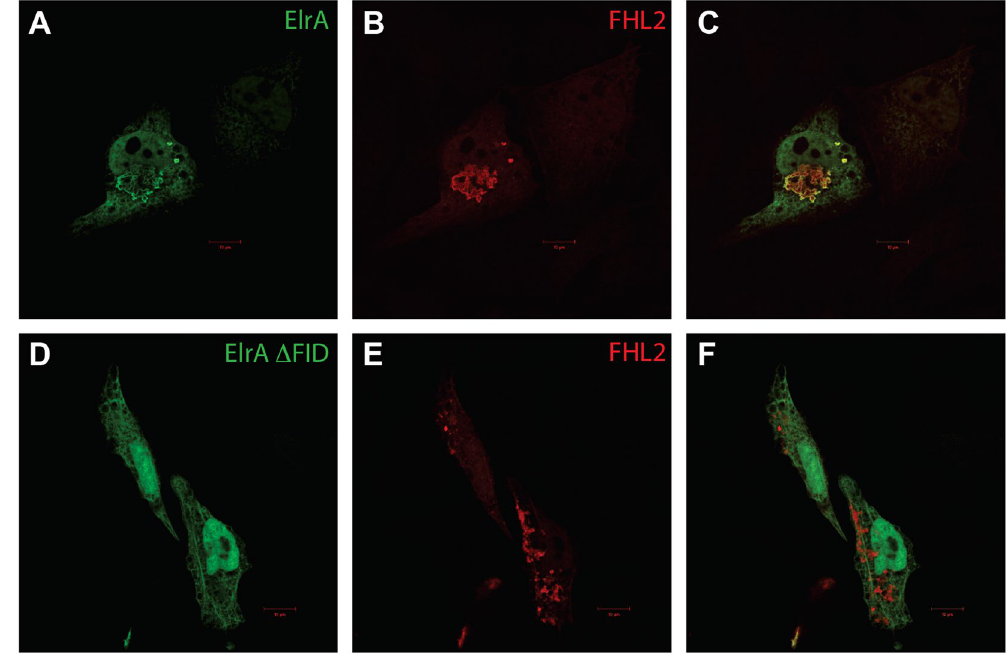
Figure 5. Cellular localisation of untruncated and FID-truncated forms of ElrA and FHL2. HA-FHL2 and myc-ElrA were produced after transfection of HeLa cells with the pCMVHA-FHL2 and pCMVmyc-ElrA 27–723 or pCMVmyc-ElrA 27–473 plasmids. A representative cell is shown for each form of myc-ElrA. In the left panels (A and D), is represented the localisation of the untruncated ( A ) and the FID-truncated ElrA ( D ) the FHL2 staining (anti-HA) is represented in the middle panels ( B and E ), and the right panels were generated by merging the anti-myc and anti-HA signals (C and F). Scale bars = 10 µ m. Localization of HA-tagged FHL2 ( B ) is similar ( C ) to the localization of an untruncated myc-ElrA (A) whereas localization of HA-tagged FHL2 ( E ) is different ( F ) to the localization of a truncated myc-ElrA ( D